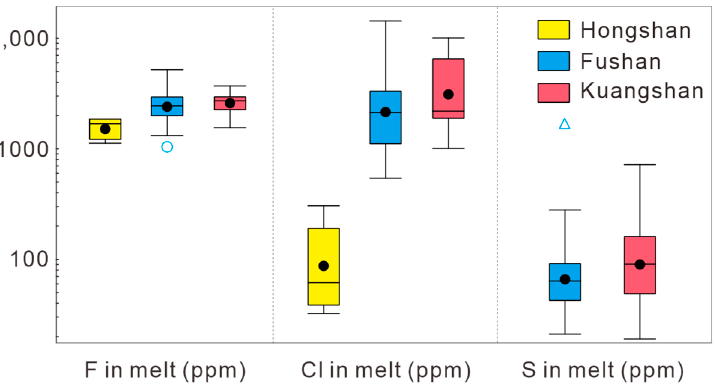
Figure 11. Boxplots of F, Cl, and S in melt ( ○ — mild outlier ; △ — extreme outlier). The data of the Hongshan complex is quoted from [78–80].